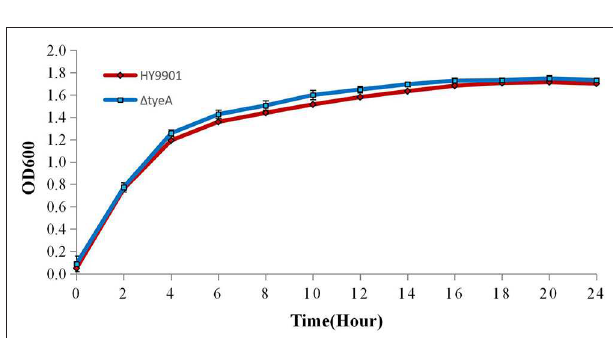
FIGURE 5 | Growth rates of HY9901 1 tyeA and HY9901. Aliquots of cell culture were taken at various time points and measured for cell density at OD 600 .